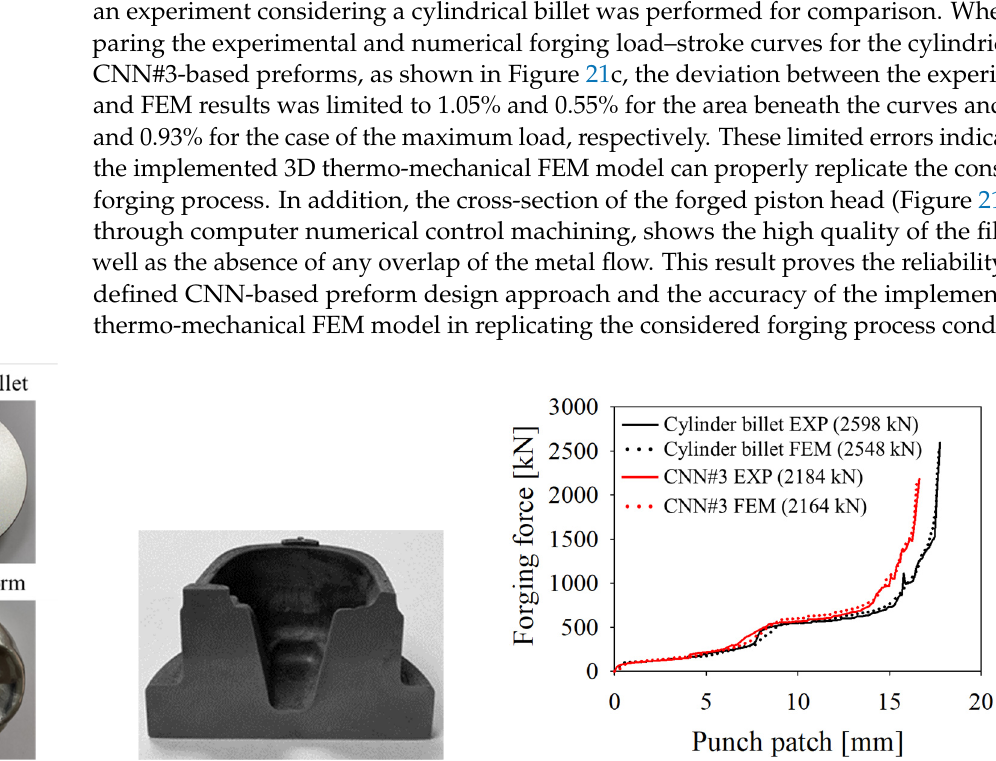
Figure 20. ( a ) Experimental set-up and ( b ) punch and die utilized in the verification experiments.